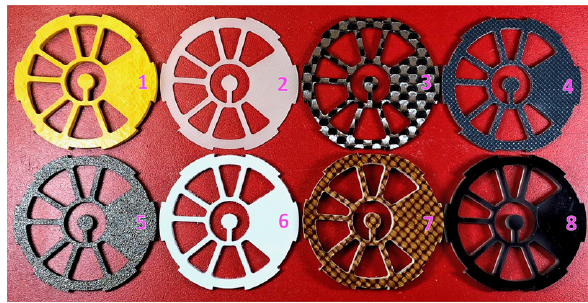
Figure 13: Collection of AWJ-machined composite